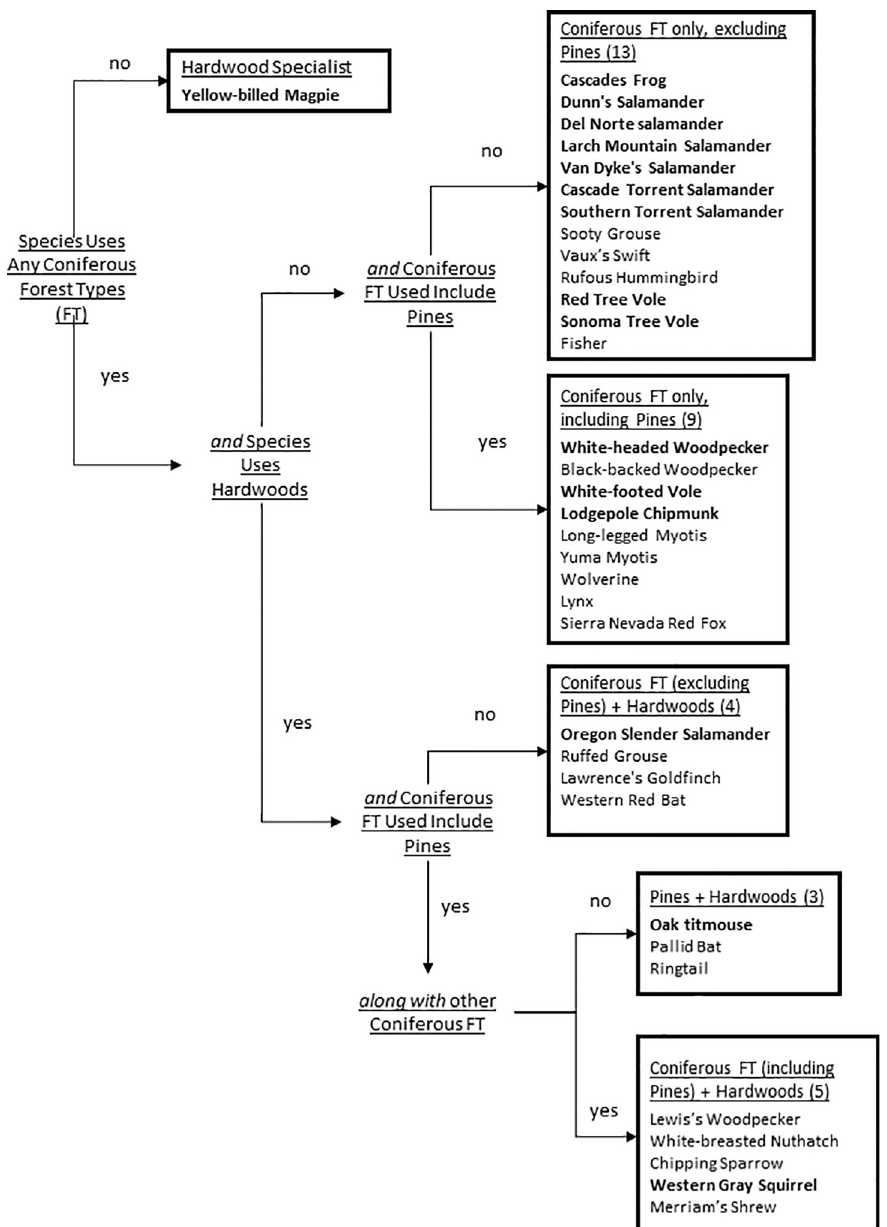
Fig 1. Classification of wildlife species by forest types used/not used (full details in S1 Table; here ‘Coniferous FT’ include Douglas-fir, fir/spruce, and hemlock/sitka spruce groups as defined by FIA forest types). Species names in BOLD indicate � 50% of that species’ range lies within our three U.S. Pacific coast states study area.